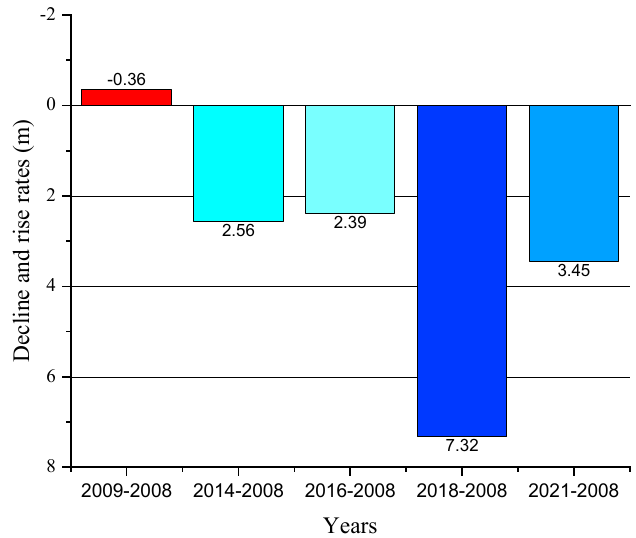
Figure 10. Decline and rise rates over the years of the observation period.